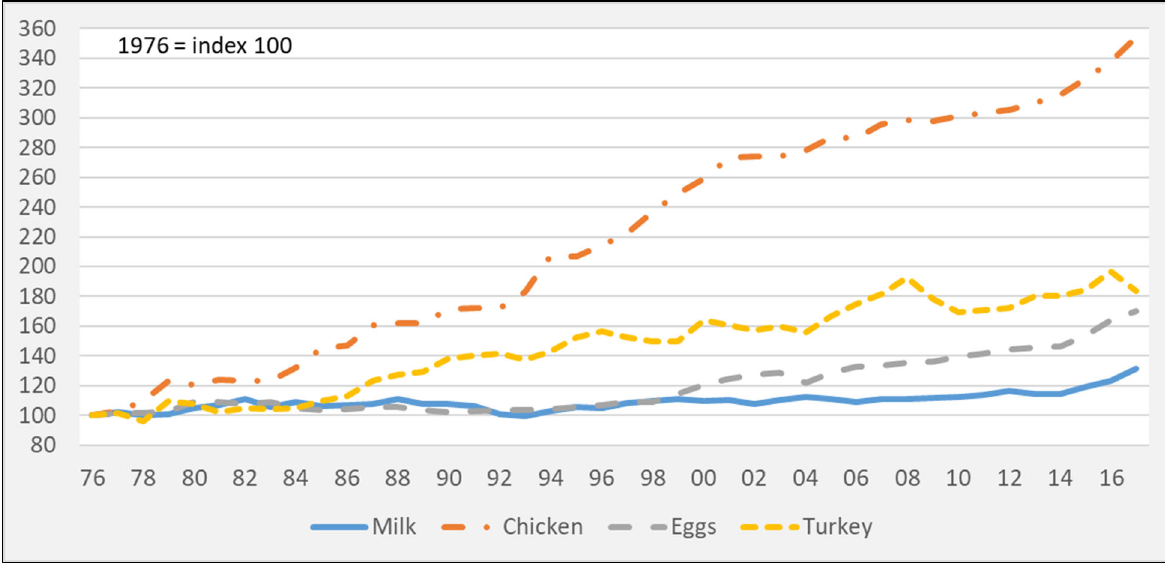
Note: The data for chicken production covers both chickens and laying hens. Egg production includes table and hatching eggs. Sources: Statistics Canada (2017b, 2017c, 2017d); our